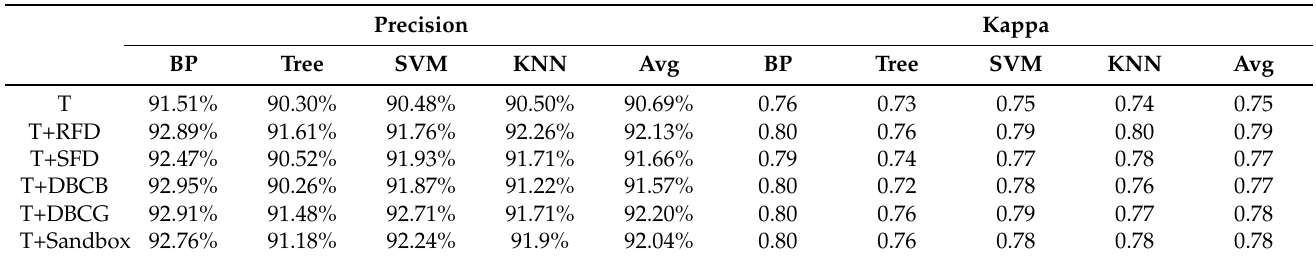
Table 1. Comparison of classification effects based on traditional attributes added with fractal